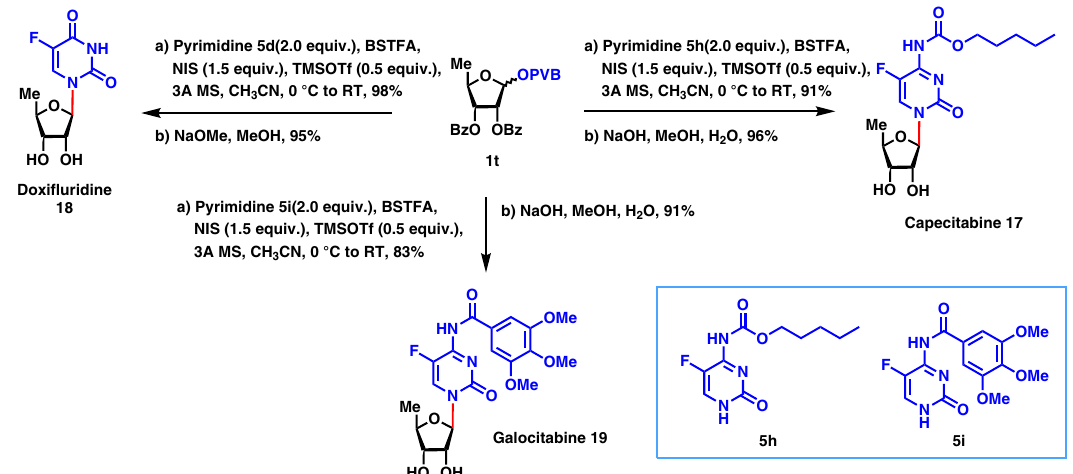
Fig. 5 Application to the synthesis of nucleosides Capecitabine 17, Doxi fl uridine 18, and Galocitabine 19. Highlighted in blue are leaving groups and nucleophilic acceptors and in red are glycosidic bonds formed.